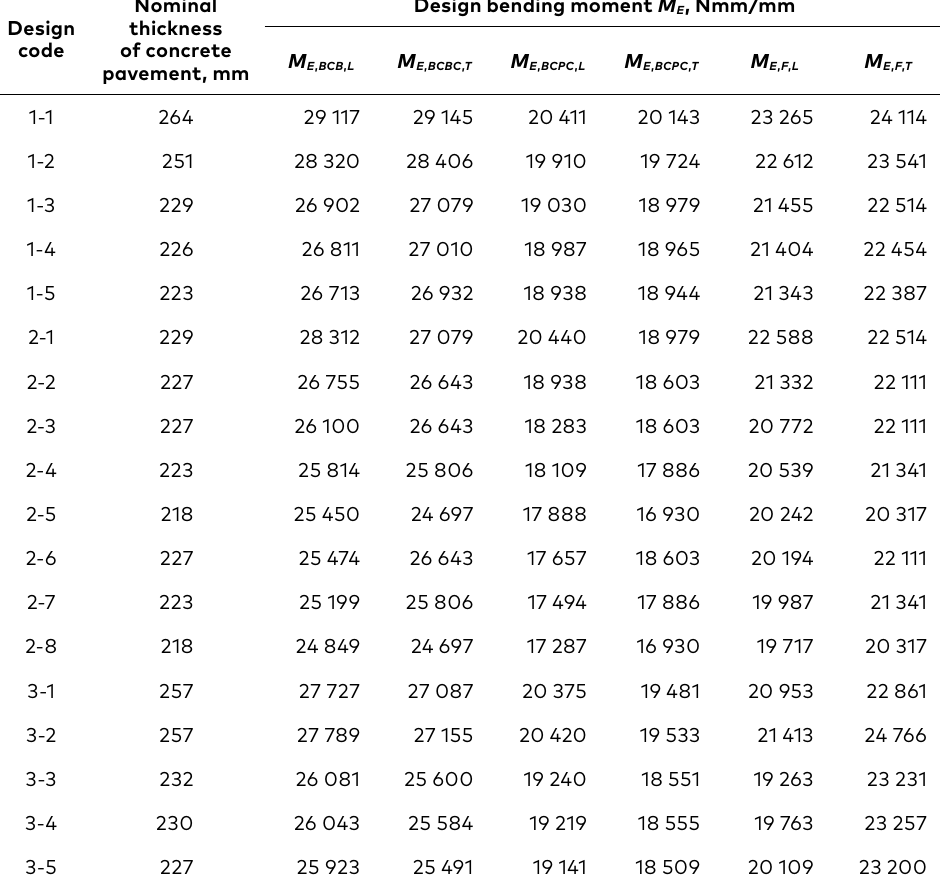
Table 10. The design bending moments for design concrete